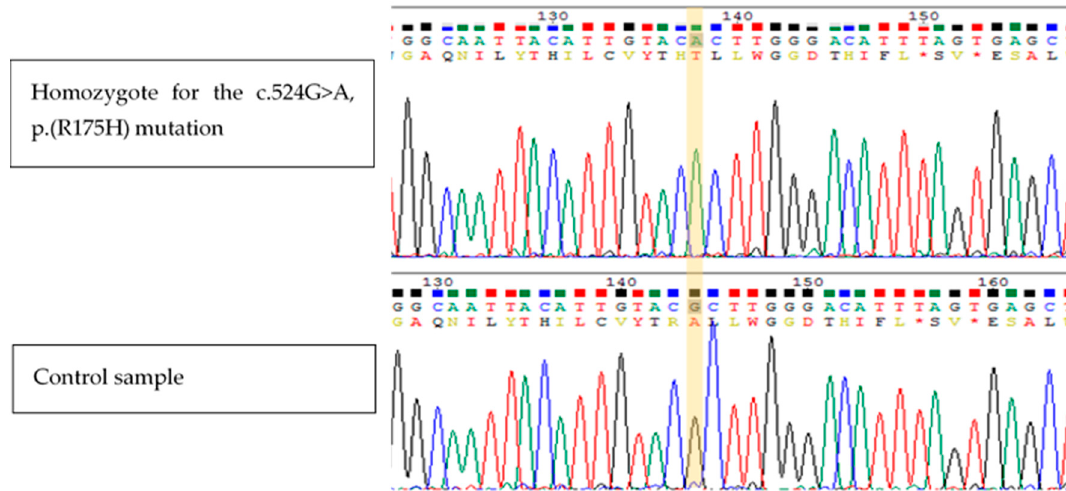
Figure 2. Sanger sequencing. Sanger sequencing for the NM_004453.3 ( ETFDH ): c.524G>A; p.(R175H) missense mutation of an affected individual and an unaffected unrelated individual.